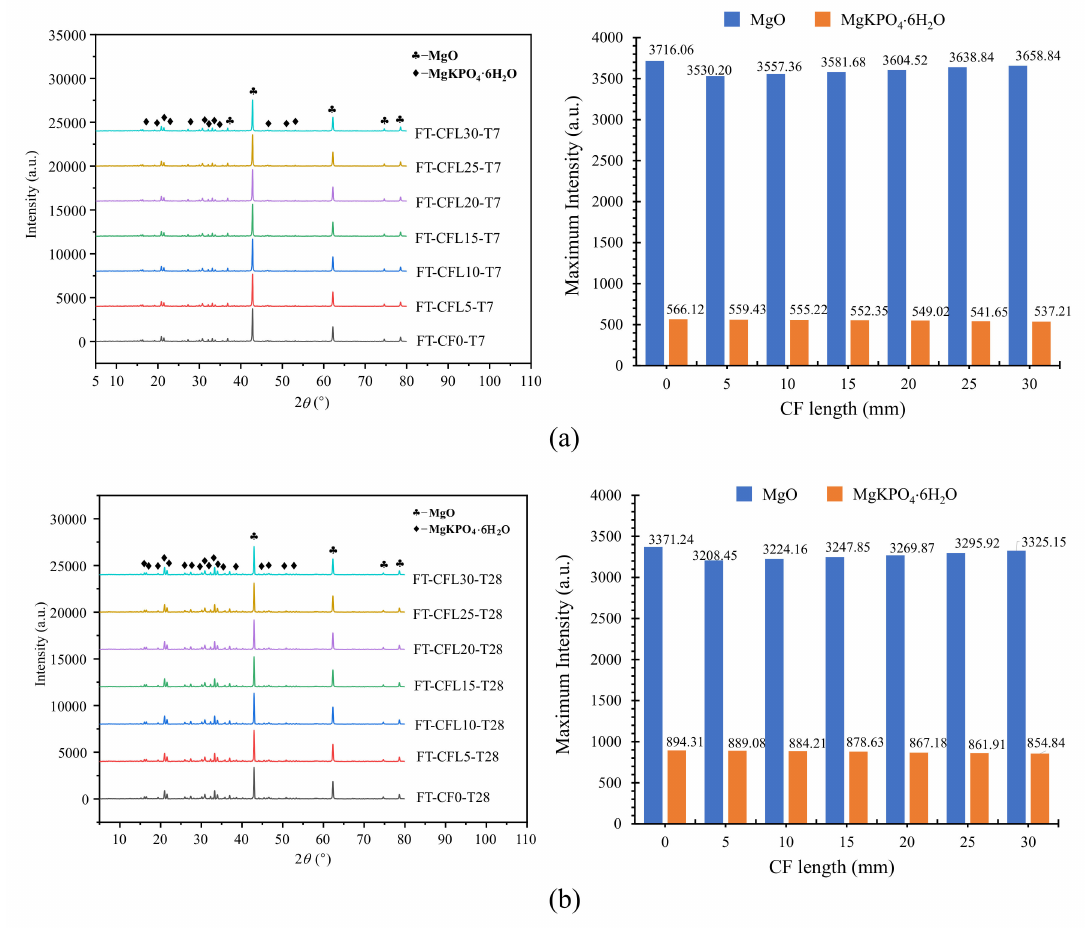
Figure 13. X-ray di ff raction (XRD) of specimens: ( a ) T7; ( b ) T28.